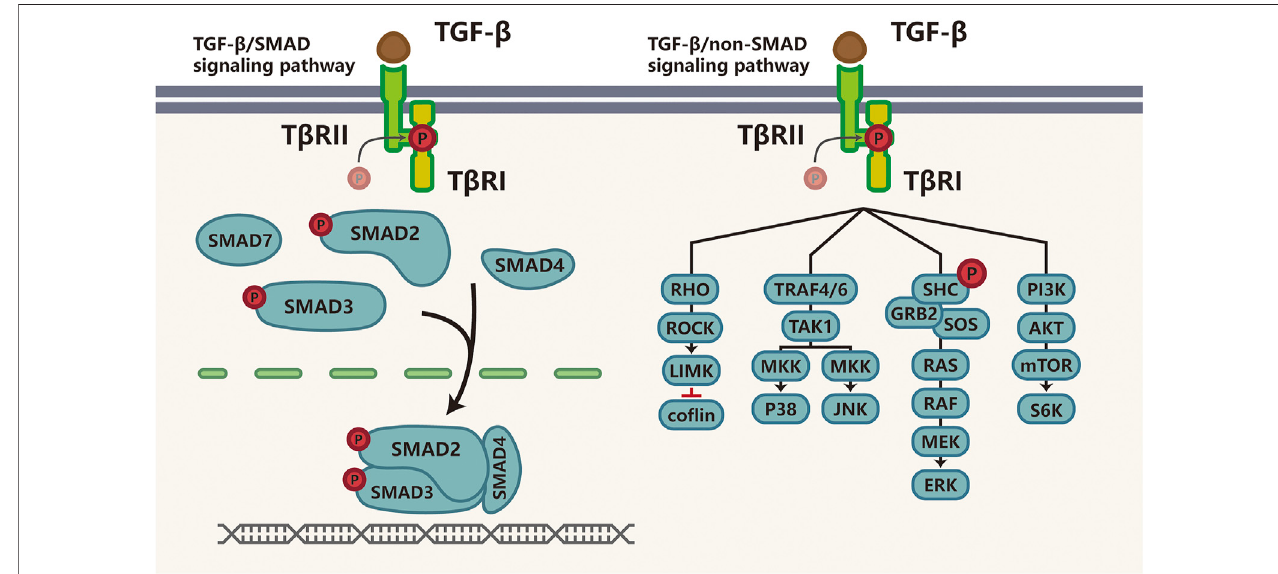
FIGURE 1 | TGF- β signaling pathway TGF- β transduces signaling through SMAD or non-SMAD signaling pathways. Actived TGF- β binds to TGF- β ligand, Once TGF- β bindstoT β RII,T β RIisrecruited,phosphorylatedandactivatedtophosphorylatethedownstreammediators-SMAD2andSMAD3;thenSMAD4bindstoactivated SMAD2 and SMAD3 to form heterotrimeric transcriptional complexes that translocate and relay this signaling into the nucleus to further regulate transcription. This is called canonical TGF- β /SMAD signaling pathway (right). The non-SMAD-dependent activation of the TGF- β pathway involves signaling via RHO GTPases, P38, JNK, ERK or MEKK, and PI3K-AKT (left). Abbreviations: P, phosphorylation; T β R, transforming growth factor (TGF)- β receptor; ROCK, RHO-associated coiled-coil containing protein kinase; LIMK, LIM kinase; TRAF, TNF receptor-associated factor; TAK1, TGF- β -activated kinase-1. JNK, c-Jun N-terminal kinase; SHC, SRC homology 2 domain-containing transforming protein; GRB2, growth factor receptor-bound protein 2; SOS, son of sevenless; MEK, mitogen-activated protein kinase; ERK, extracellular signal-regulated kinase; PI3K, phosphatidylinositol-4,5-bisphosphate; mTOR, mechanistic target of rapamycin.